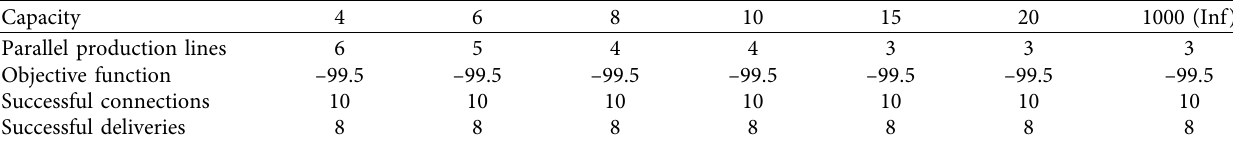
Table 6: Variation with respect to the production line capacity.